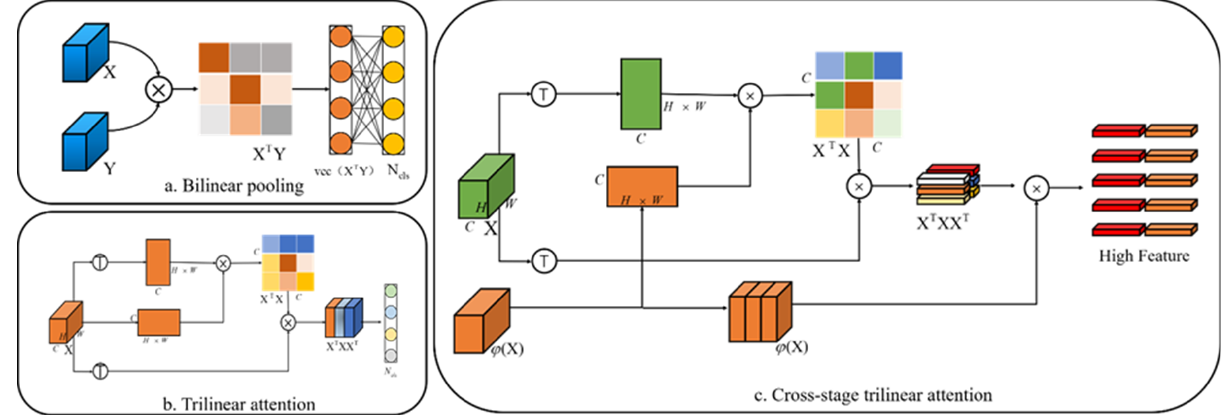
Figure 3. Cross ‐ stage trilinear attention fine ‐ grained feature learning module: ( a ) bilinear pooling; Figure 3. Cross-stage trilinear attention fine-grained feature learning module: ( a ) bilinear pooling; ( b ) triple linear attention; ( c ) cross ‐ stage trilinear attention. ( b ) triple linear attention; ( c ) cross-stage trilinear